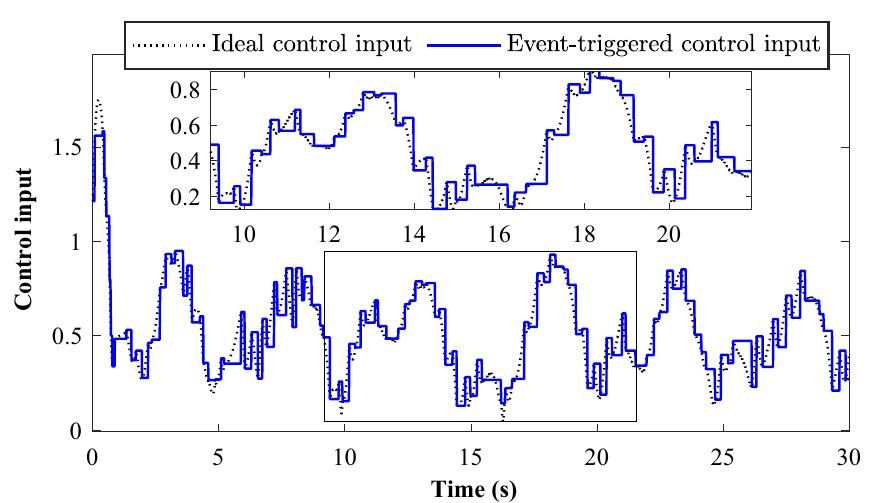
u u i ( t ) � , where ˜ i ( t ) is described in (14) with event-triggered strategy, the �˜ u u i ( t ) � , where ˜ i ( t ) is described in (13) without event-triggered �˜